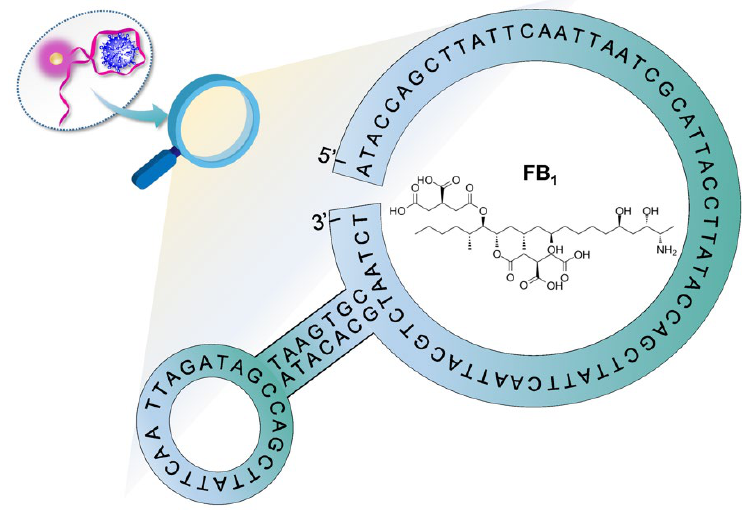
Figure 5. Illustration of the aptamer and its specific interactions with target fumonisin B 1